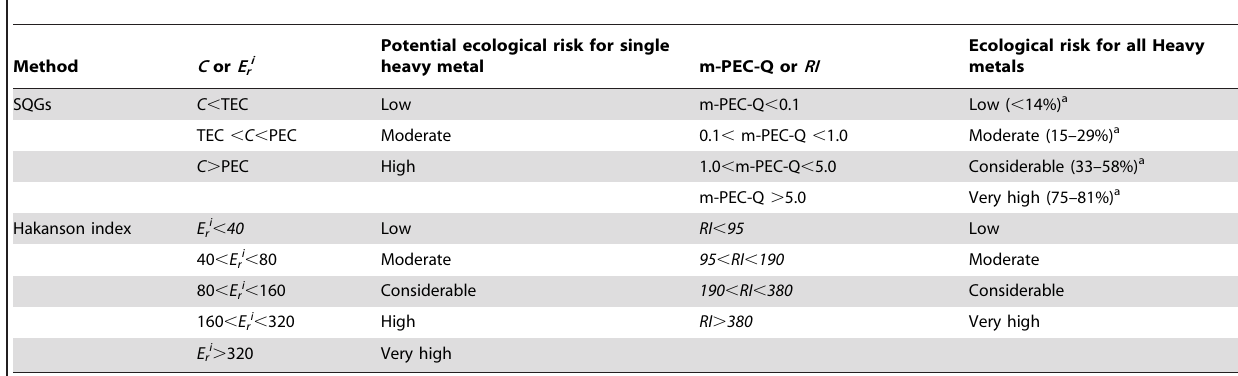
Table 2. Ecological risk assessment criteria for the sediment quality guidelines (SQGs) and Hakanson index.